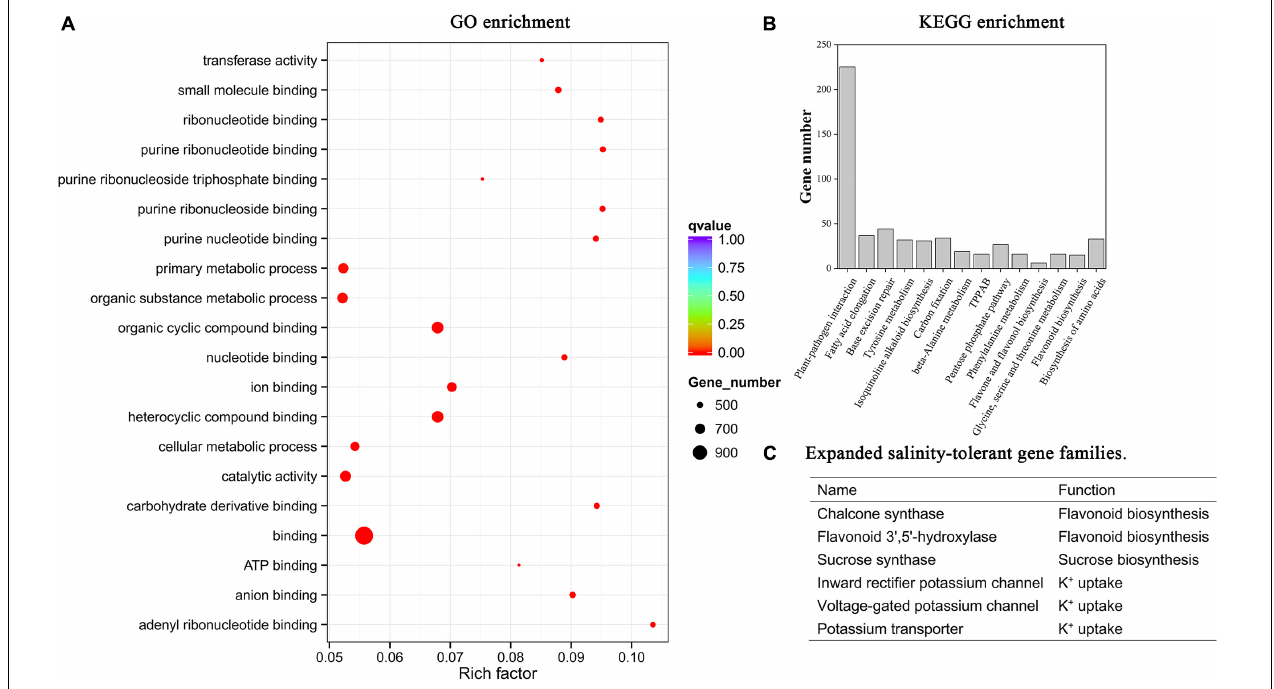
FIGURE 2 | Gene family expansion analysis of P. tenuiflora during evolutionary history. Gene family expansion analysis was conducted using OrthoMCL and Cafe software. (A) GO enrichment of P. tenuiflora gene families that expanded during evolutionary history. Only the top 20 enriched GO terms are displayed. (B) KEGG enrichment of the P. tenuiflora gene families that expanded during evolutionary history. Only the enriched KEGG pathways with adjusted P -values < 0.05 are displayed. (C) Expanded salinity-tolerant gene families of P. tenuiflora during evolutionary